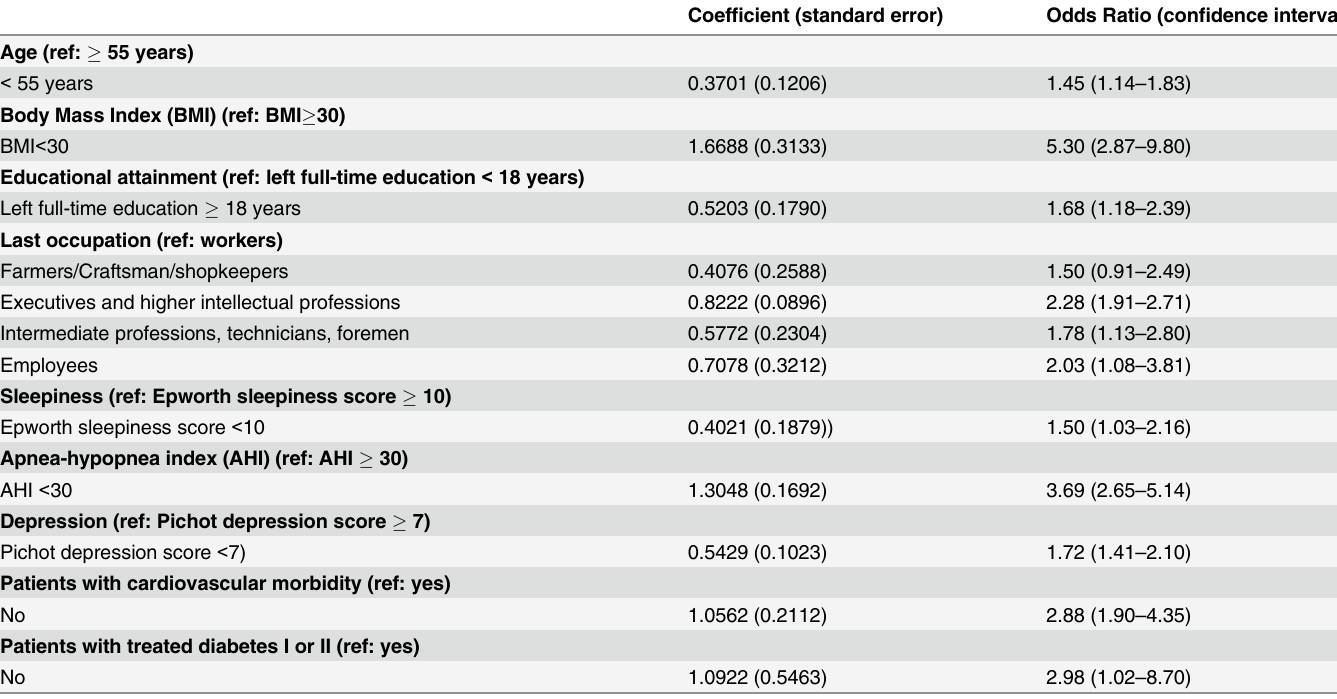
Table 3. Stepwise marginal regression analysis of variables influencing MAD therapy with center as a cluster variable (n =